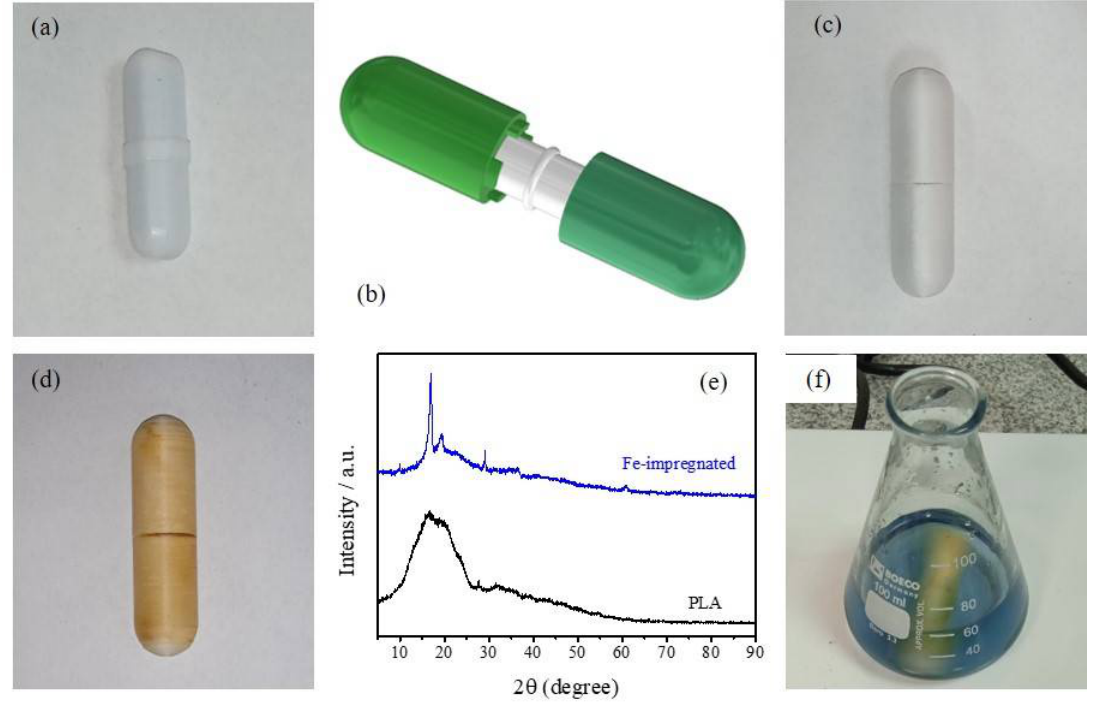
Figure 5. ( a ) Common lab stirrer, ( b , c ) schematic CAD representation and picture of a 3D-printed stirrer cap assembly, respectively, ( d ) Fe-impregnated stirrer cap assembly, ( e ) XRD pattern of PLA and Fe-impregnated surface, and ( f ) Fenton reaction with impregnated stirrer cap.